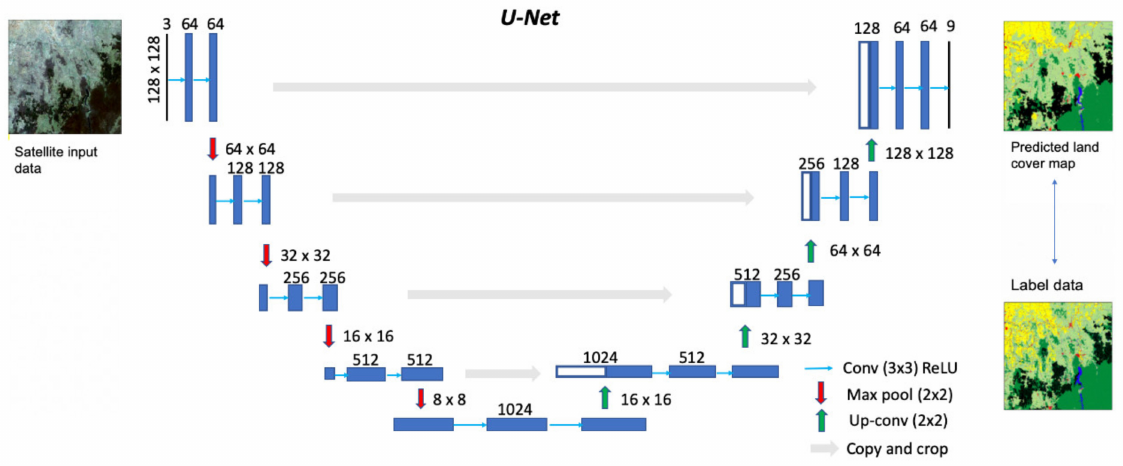
Figure 3. Base U-Net architecture after Ronneberger et al. (2015, Figure 1)